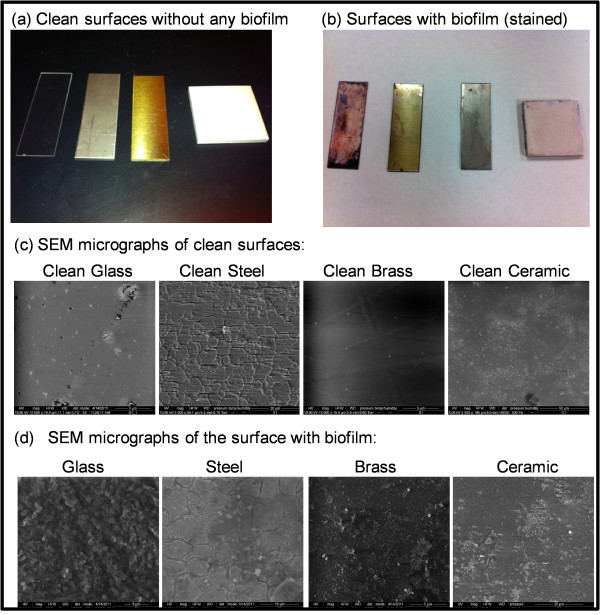
Images of substrates with and without biofilm and their corresponding SEM micrographs: (a) Photographs of the clean coupons before any biofilm was grown on it, (b) Photograph showing the coupons after the growth of biofilm on the surface with Gram staining and (c) SEM micrographs the clean coupons before the growth of biofilms (Left to Right: Glass, Steel, Brass and Ceramic) and (d) SEM micrographs of the coupons with biofilm (Left to Right: Glass, Steel, Brass and Ceramic).